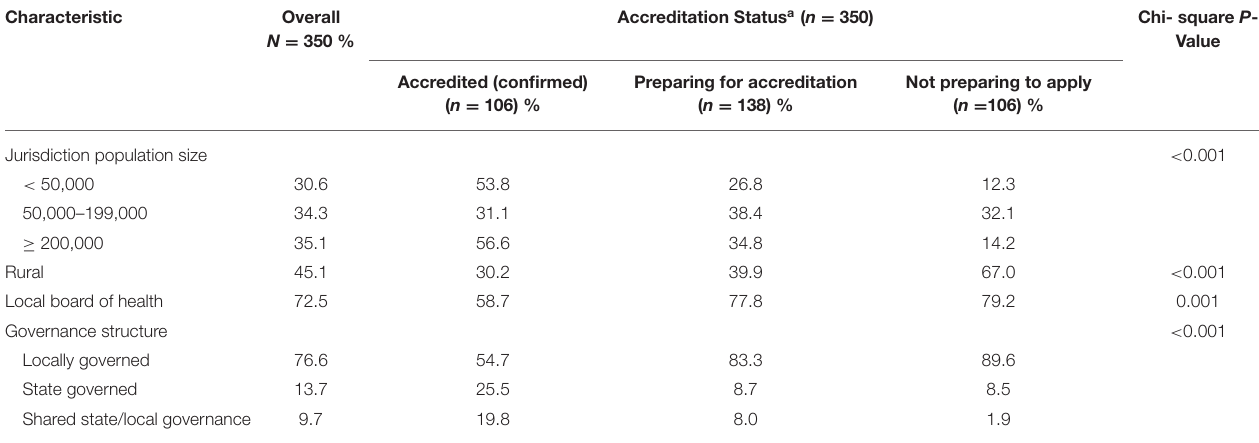
TABLE 2 | Local health department characteristics, by accreditation status, from a 2017 sample of U.S. local health department chronic disease prevention directors.